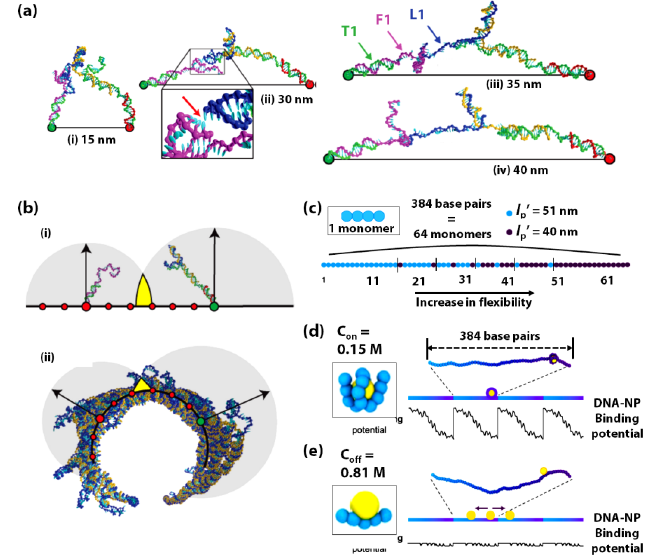
Figure 8. ( a ) Brownian dynamics simulations of coarse-grained models of the transition state configurations of the DNA bipedal walker, illustrating the increasingly stretched nature of the walker at (i) 15 nm, (ii) 30 nm, (iii) 35 nm, and (iv) 40 nm step sizes, with T1, F1, and L1 being one of the two the ‘foothold strand’, ‘Fuel strand’, and ‘Leg strand’. The red arrow in (ii) indicates the position of a leg-placing base pair. ( b ) Schematic of the DNA bipedal walker (blue-orange) with (i) one foot up and the other down on a flat surface, and (ii) an axial view of the configuration of the 2D origami sheet curled up into a tubular structure, with the red circles denoting the short axis foothold positions. The step size (~32 nm) is denoted by the larger green and red circles, which is the same for both (i) and (ii). The gray circles in both (i) and (ii) represent the regions of space well-sampled (95% of configurations have their terminal base within the sphere) by the unbound section of the walker (blue) and the foothold-bound fuel (purple) when the secondary structure was forbidden in the simulations. Arrows represent the radii of the spheres, and the yellow colour indicates the overlap between the spheres. ( a , b ) are adapted with permission from [212]. Copyright 2017, the authors. ( c ) Schematic of the dsDNA fragment modelled by a chain of 64 monomers (1 monomer = 6 basepairs) with flexibility gradient. The local persistence length ( L p ’) is set for each monomer at either 51 or 40 nm. The sequence-dependent dsDNA flexibility is gradually increased by increasing the fraction of monomers with L p ’ = 40 nm. Schematic of the long dsDNA containing four repeat fragments with the flexibility gradient, together with its DNA-NP binding potential energy along the entire dsDNA molecule at solution salt concentrations of ( d ) Con = 0.15 M and ( e ) Coff = 0.81 M, respectively. The inset in ( d , e ) shows the specific representative configuration of DNA-NP complex for which the bending energy is calculated. ( c – e ) are adapted with permission from [213]. Copyright 2019, the authors.